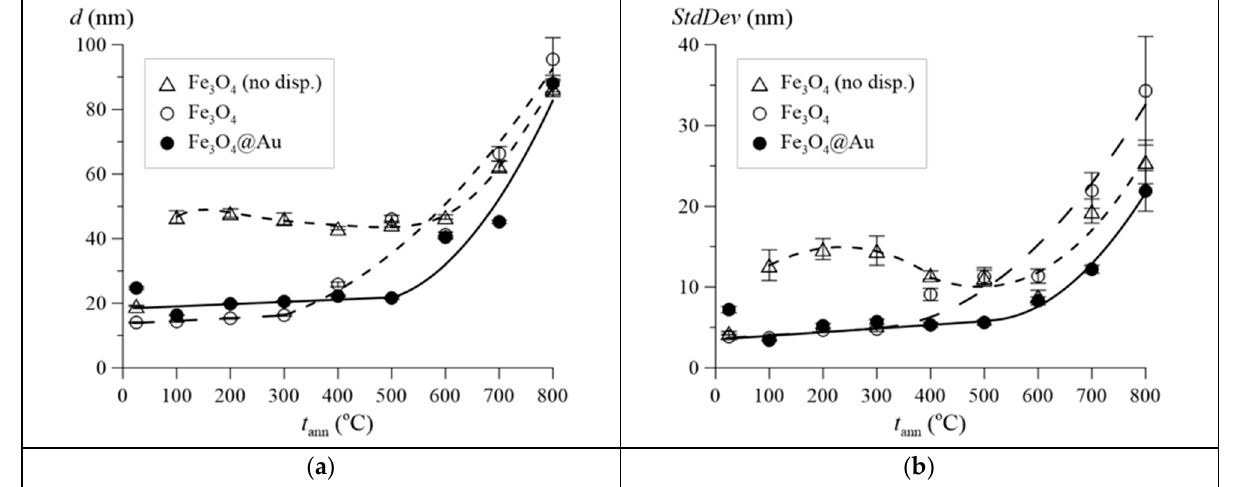
Figure 2. Results of evaluation of average nanoparticle sizes ( a ) and standard deviation of nanopar- ticle size distribution ( b ) as a function of annealing temperature t ann.